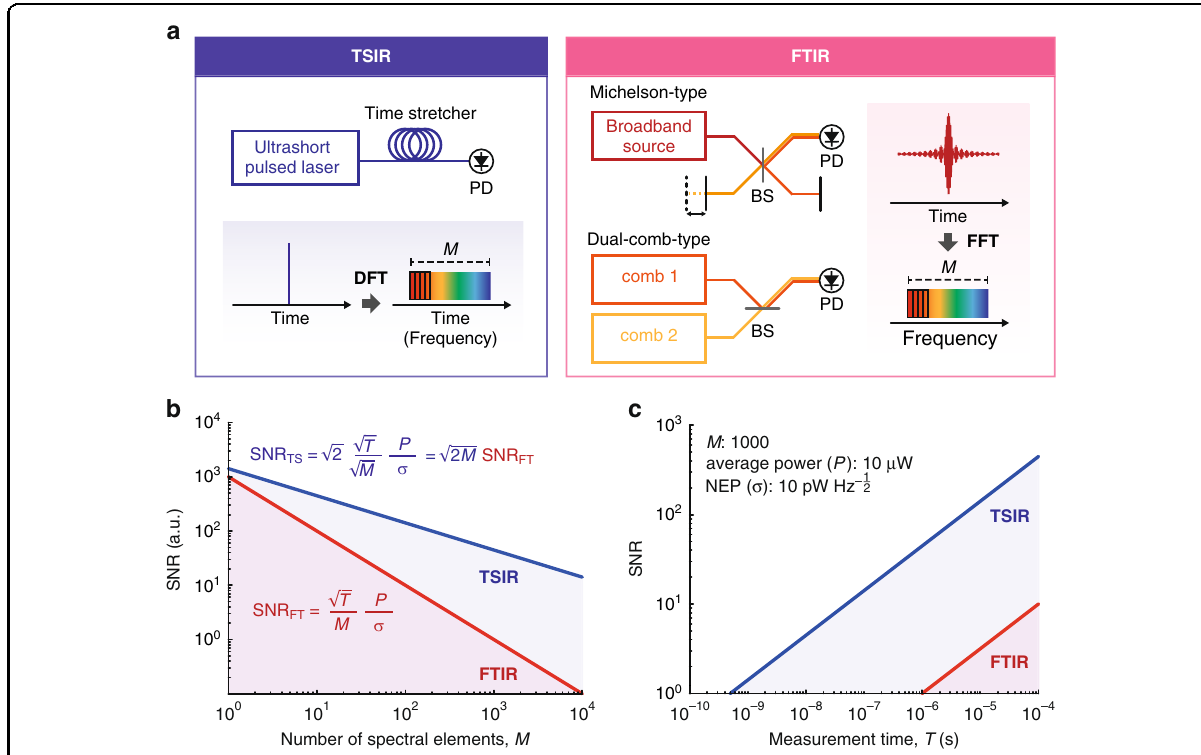
Fig. 1 Comparison of working principle and SNR between TSIR and FTIR. a Working principle of TSIR and FTIR. DFT dispersive Fourier-transform, FFT Fast-Fourier transform, BS beamsplitter, PD photodetector. b SNR dependence on the number of spectral elements, M (Blue: TSIR, Red: FTIR). P : average detection power, σ system ’ s overall noise equivalent power. c SNR dependence on measurement time, T (Blue: TSIR, Red: FTIR). The SNR is calculated for M = 1000 with typical values of P = 10 µW and σ = 10 pW Hz (cid:2) 1 2 . NEP noise-equivalent